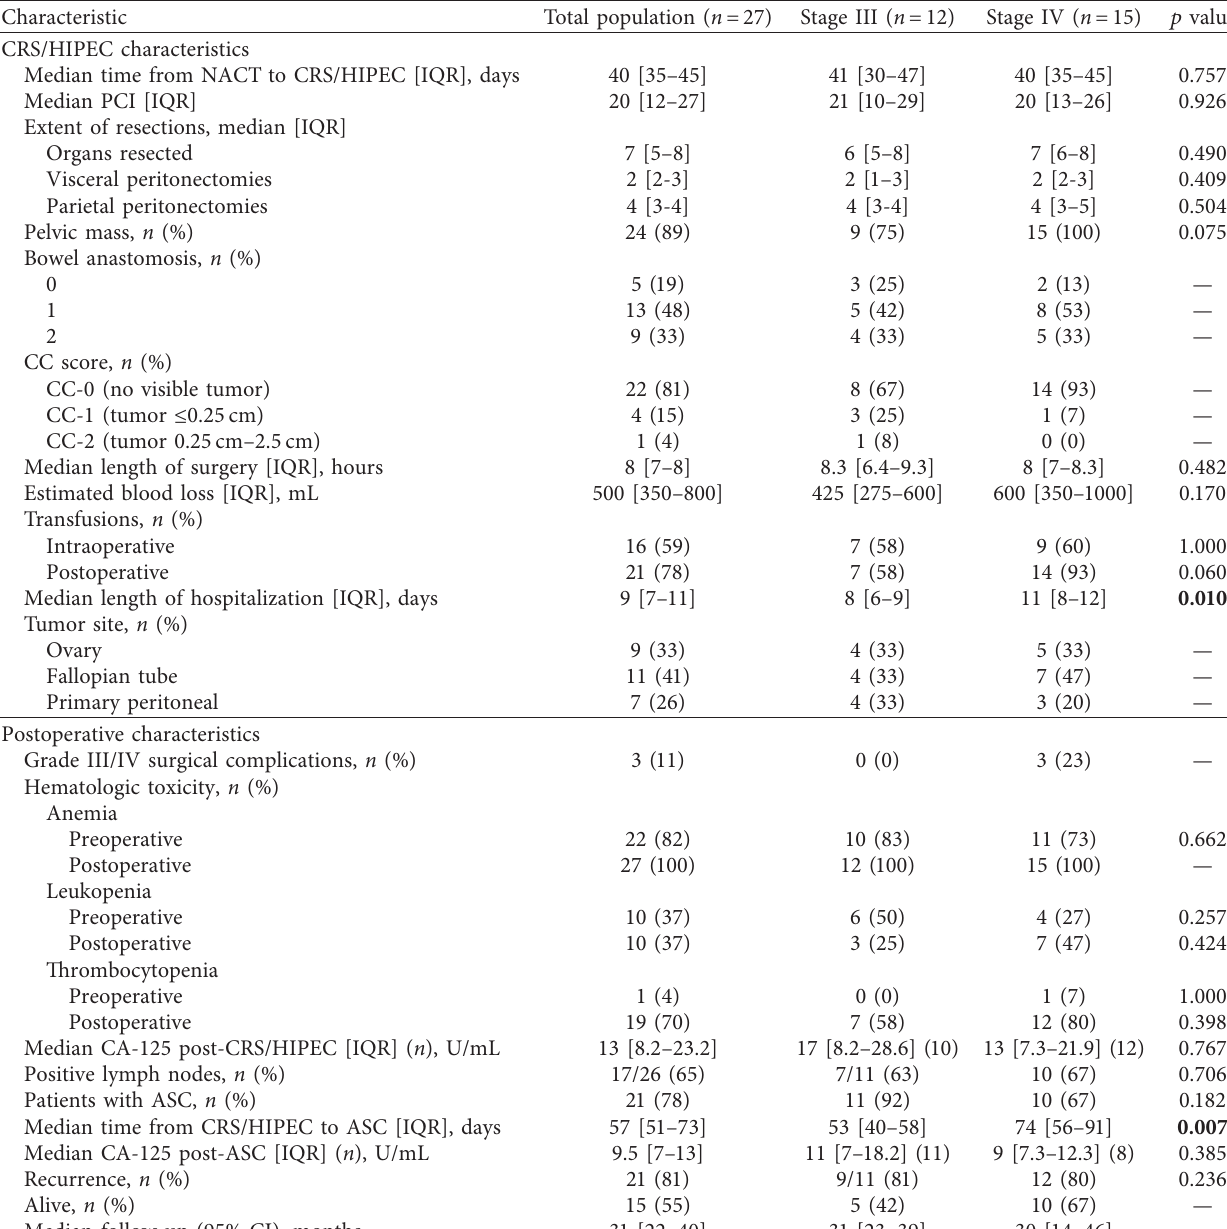
Table 2: CRS/HIPEC and postoperative characteristics by